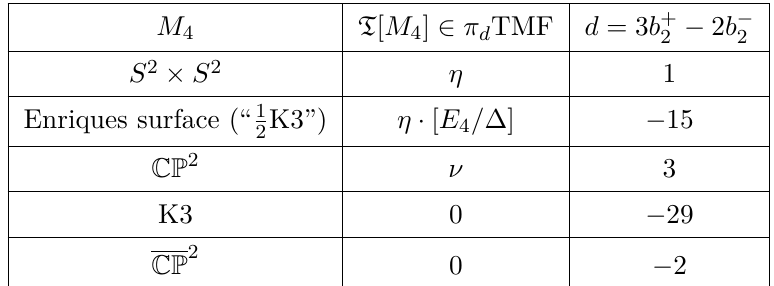
Table 1 . Some examples of values of the map T : { 4-manifolds } → π ∗ TMF. As in the rest of the paper η and ν denote the generators of π a generator of π TMF that will be explained later. The graded ring π − 16 subring of π TMF := π tmf [∆ − 24 ] ∗ ∗